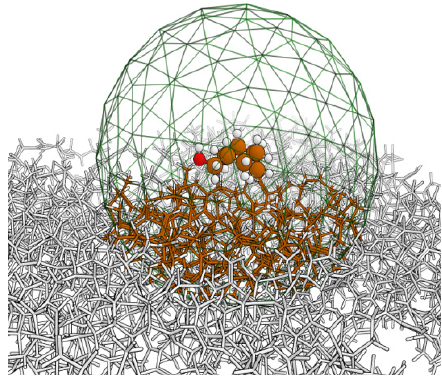
Figure 2. QM/MM partitioning of an MCHM molecule adsorbed on an amorphous carbon surface model. The green mesh indicates the QM boundary; atoms (colored) within the mesh are subject to higher-level quantum mechanical methods, while those outside the boundary are treated with molecular mechanics forcefields. Adapted with permission from Alexander, W.A., Molecules , MDPI, 2021 [12].